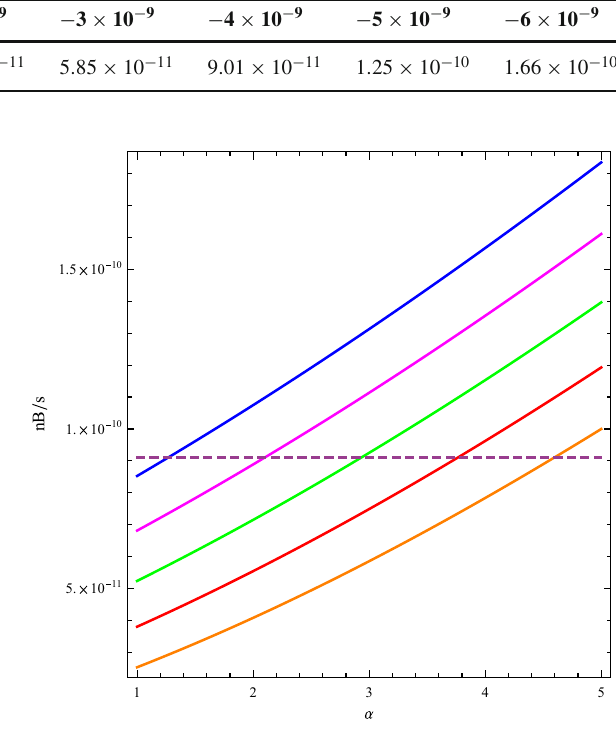
Fig. 2 The baryon to entropy ratio for the model f ( R , T ) = R + α T + β T 2 in function of α . The graphs are plotted for γ = 0 . 13 and for the varying values of β , β = − 3 × 10 − 10 (blue), β = − 2 . 5 × 10 − 10 (magenta), β = − 2 × 10 − 10 (green), β = − 1 . 5 × 10 − 10 (red), β = − 10 − 10 (orange) and dashed curve, the observational